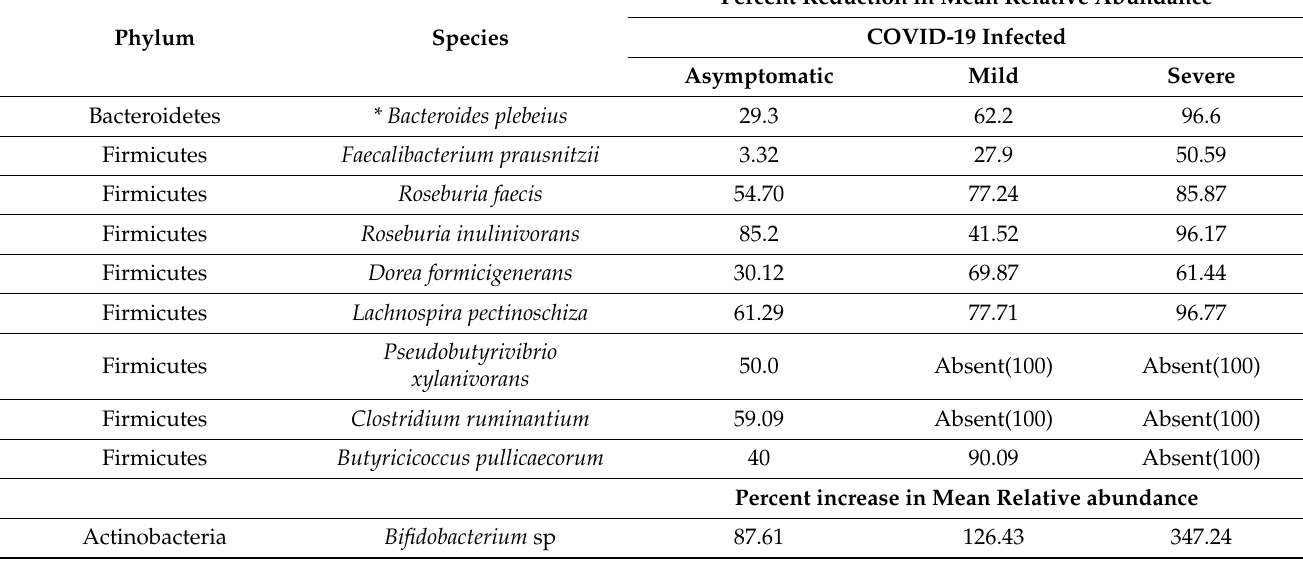
Table 3. Change in the Mean Relative Abundance of fibre-degrading bacterial species in the guts of COVID-19-infected patients. Bacterial phyla and species were identified in the faeces after next-generation sequencing. Reference control is the phyla and species found in healthy guts.